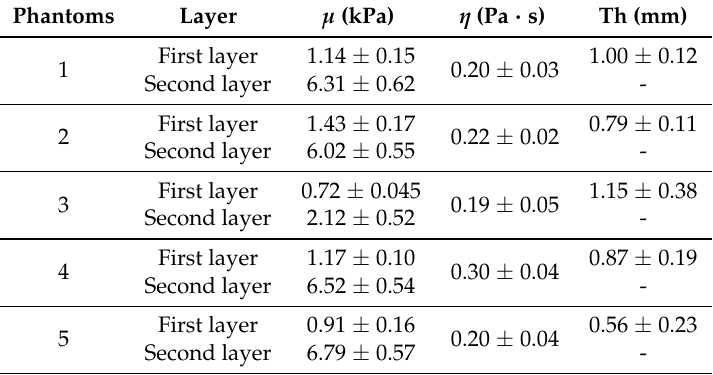
Table 9. Kelvin Voigt parameters reconstruction from TWE. Data from the first and second layer is shown (shear elasticity and shear viscosity), including the thickness of the first layer for each of the five phantoms.